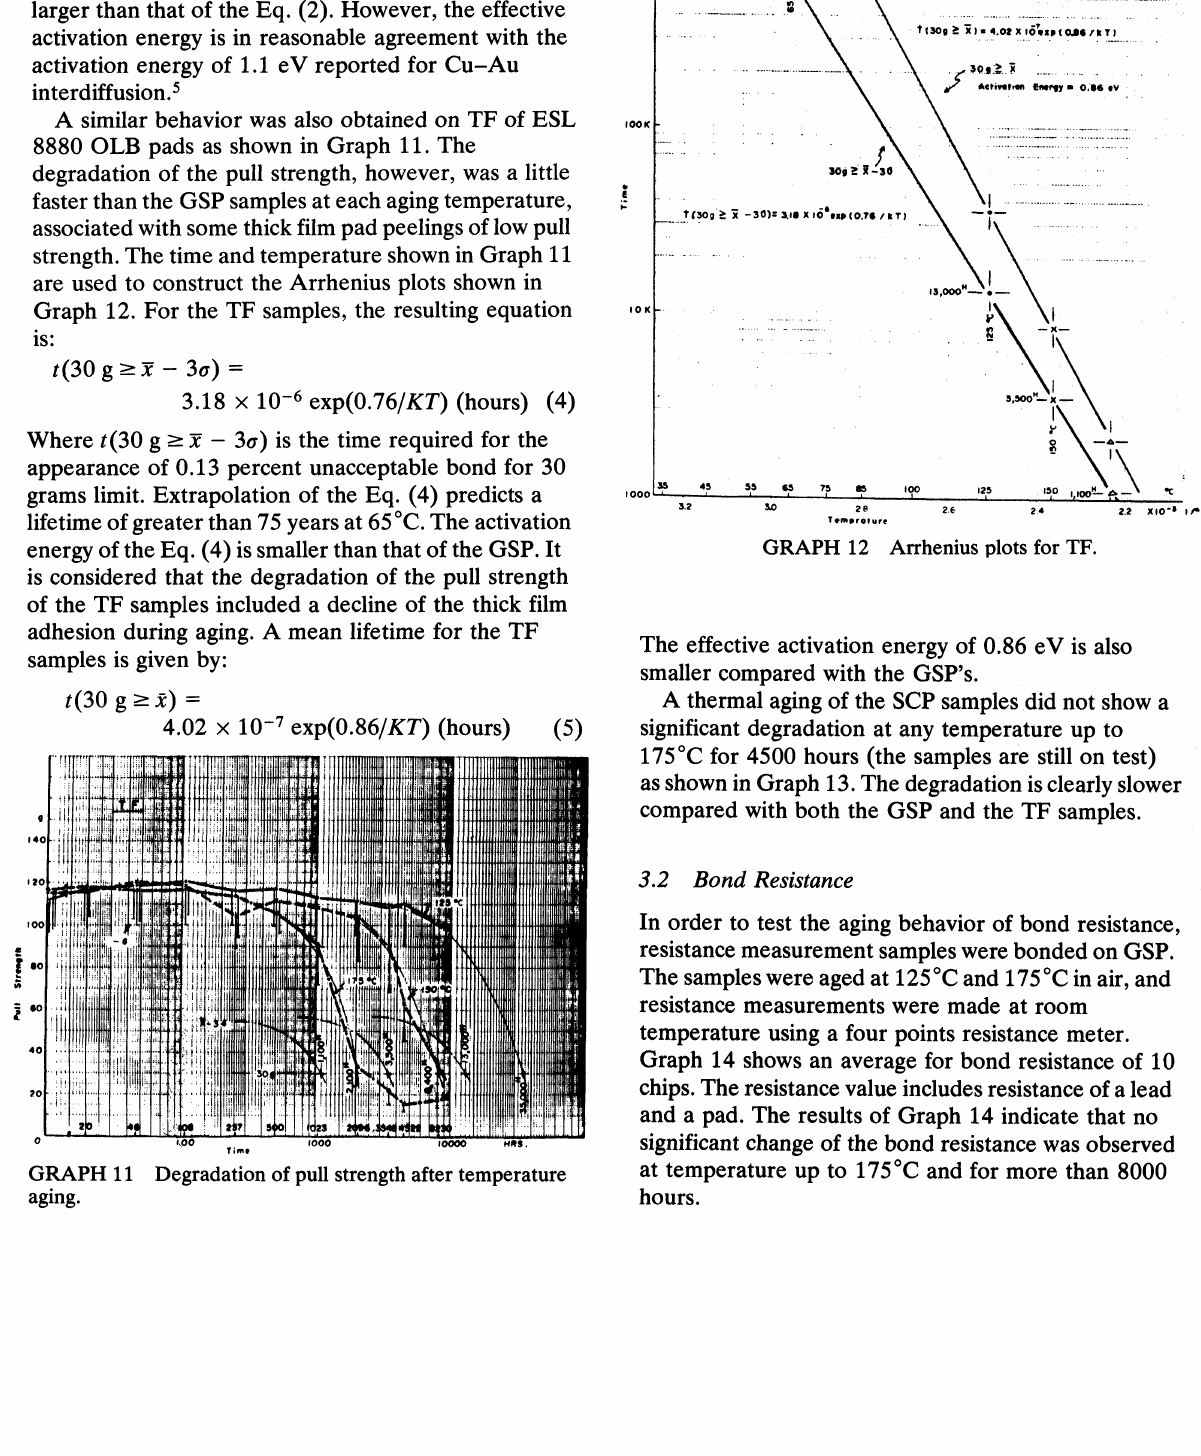
GPPH 11 Degradation of pull strength after temperature aging.